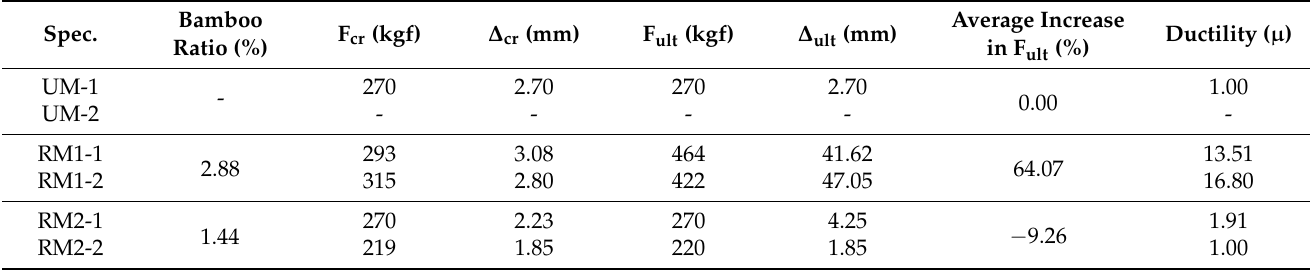
Table 5. The summary of the pushover shear test